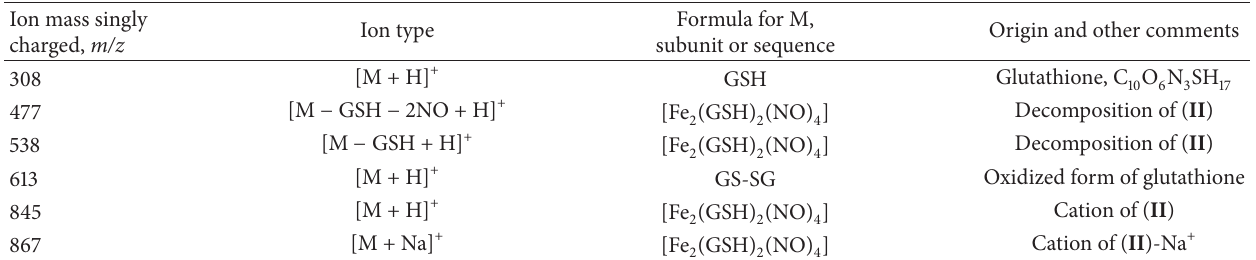
Table 3: The results of mass spectrometry (Figure 9).